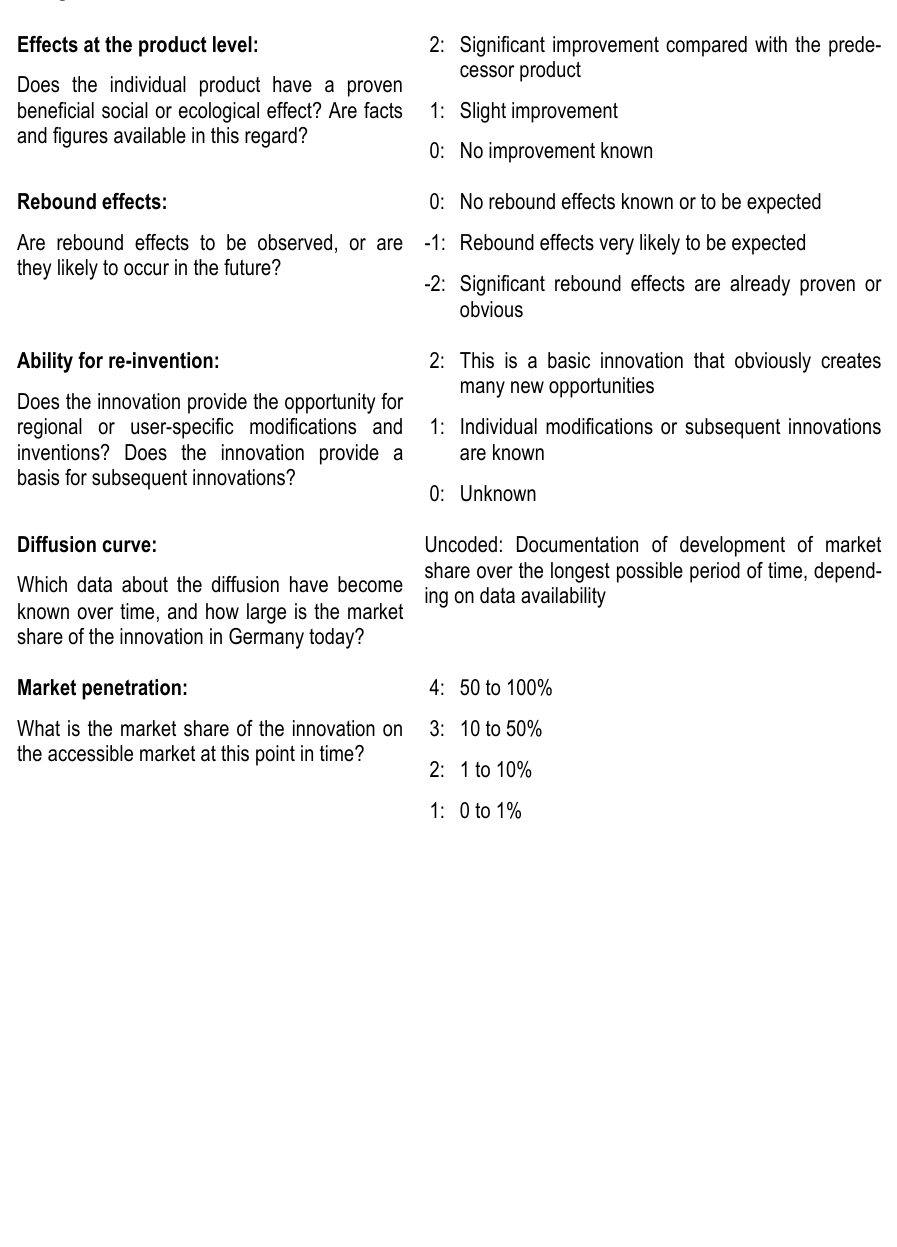
Table 10. Code system for the assessment of factors in diffusion cases Categories of